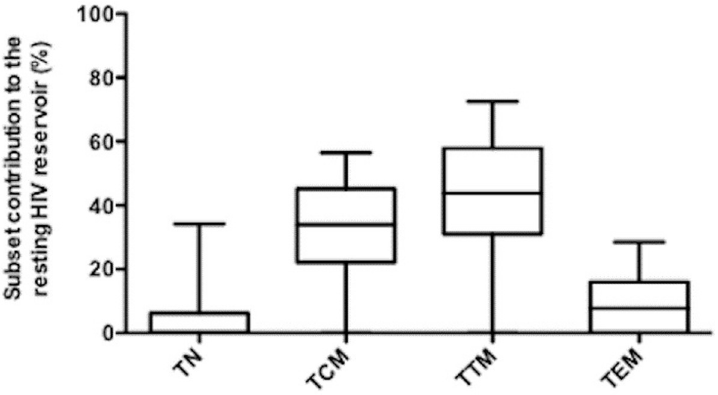
Fig 4. The CD4 T-cell subsets contribution to the resting HIV-2 reservoir considering both infection levels and frequency. Resting CD4 T-cells: naive (TN; CD45RA+CCR7+CD27+) central-memory (TCM; CD45RA-CCR7+CD27 +) transitional memory (TTM; CD45RA-CCR7-CD27+) and effector-memory cells (TEM; CD45RA-CCR7-CD27-) are represented from 14 HIV-2 infected subjects. The results are expressed as the median percentage of the resting CD4 T-cells HIV-2 reservoir, with interquartile range [25%–75%] and minimum and maximum